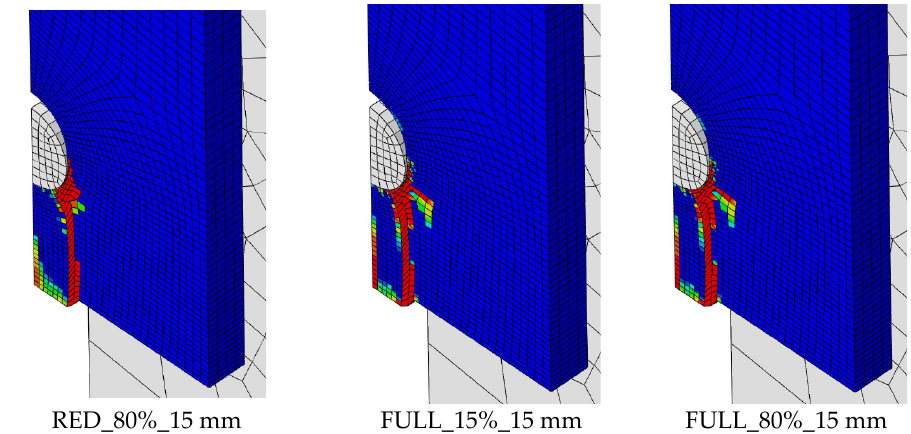
Figure 19. Final shear damage distribution for 70 mm of cover for the double-lap test, with re- duced/full integration (RED/FULL) with 15% and 80% residual compressive stress.